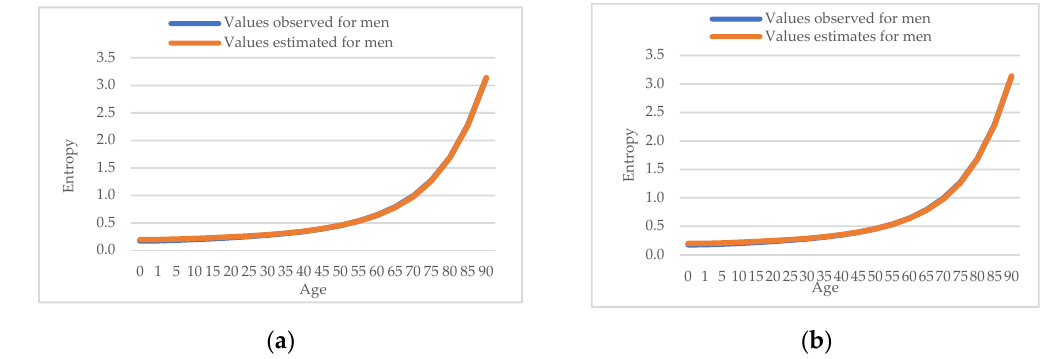
Figure 6. ( a ) Adjustment for the case of Spain; ( b ) adjustment for the case of Japan. Source: authors. It can be seen at a glance that the two curves practically overlap in both countries.